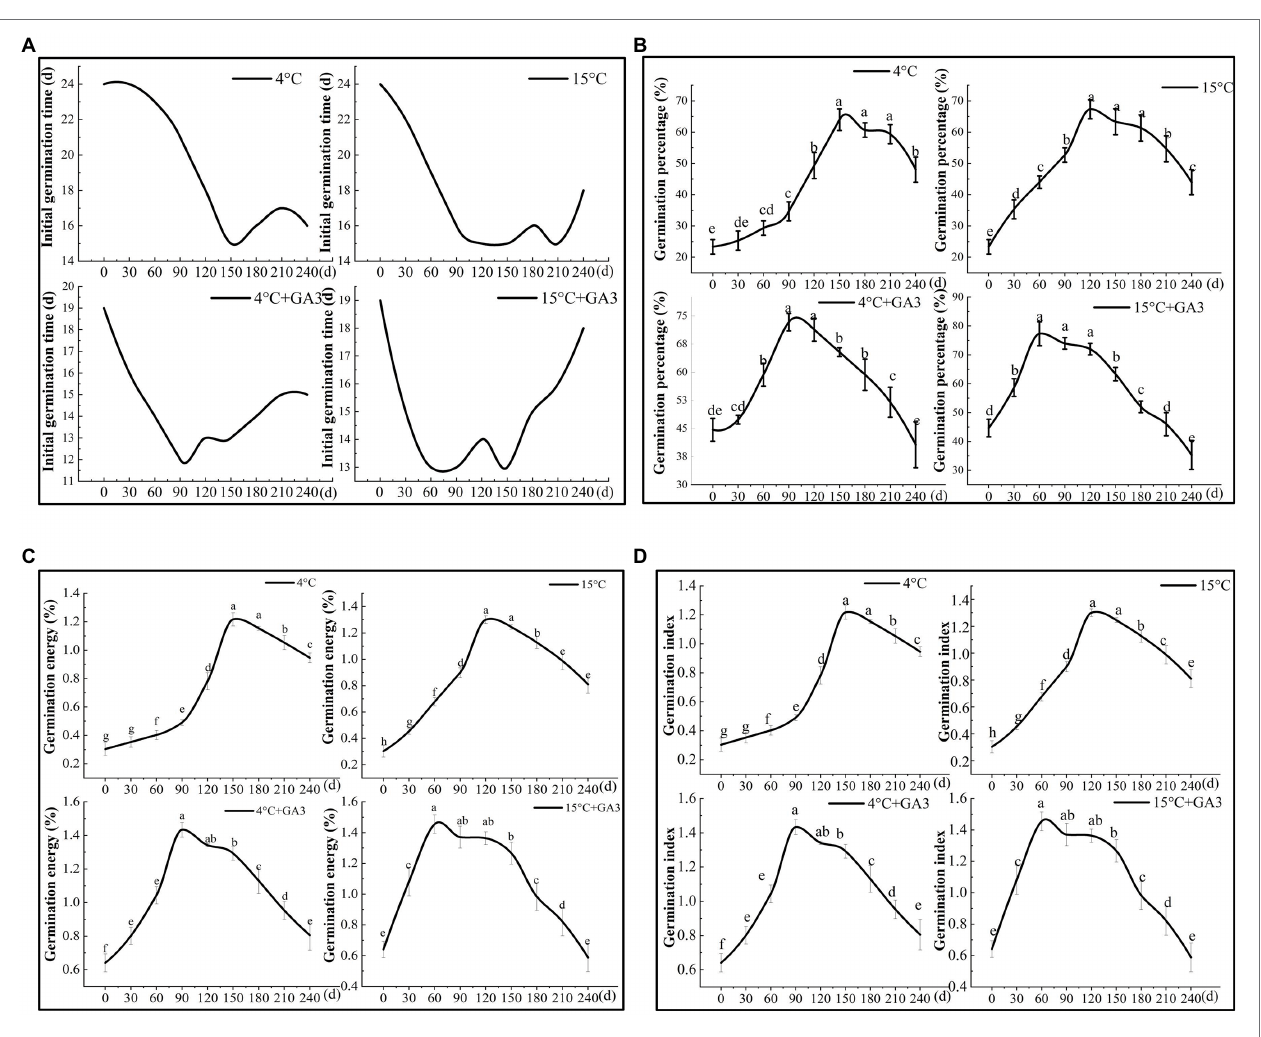
FIGURE 9 | Effects of stratification on the germination characteristics of Cinnamomum migao seeds. Data are presented as means ± standard deviations ( n = 3), and the values marked with different letters in different treatments vary significantly ( p < 0.05). Three replicates of 50 seeds were used in the germination